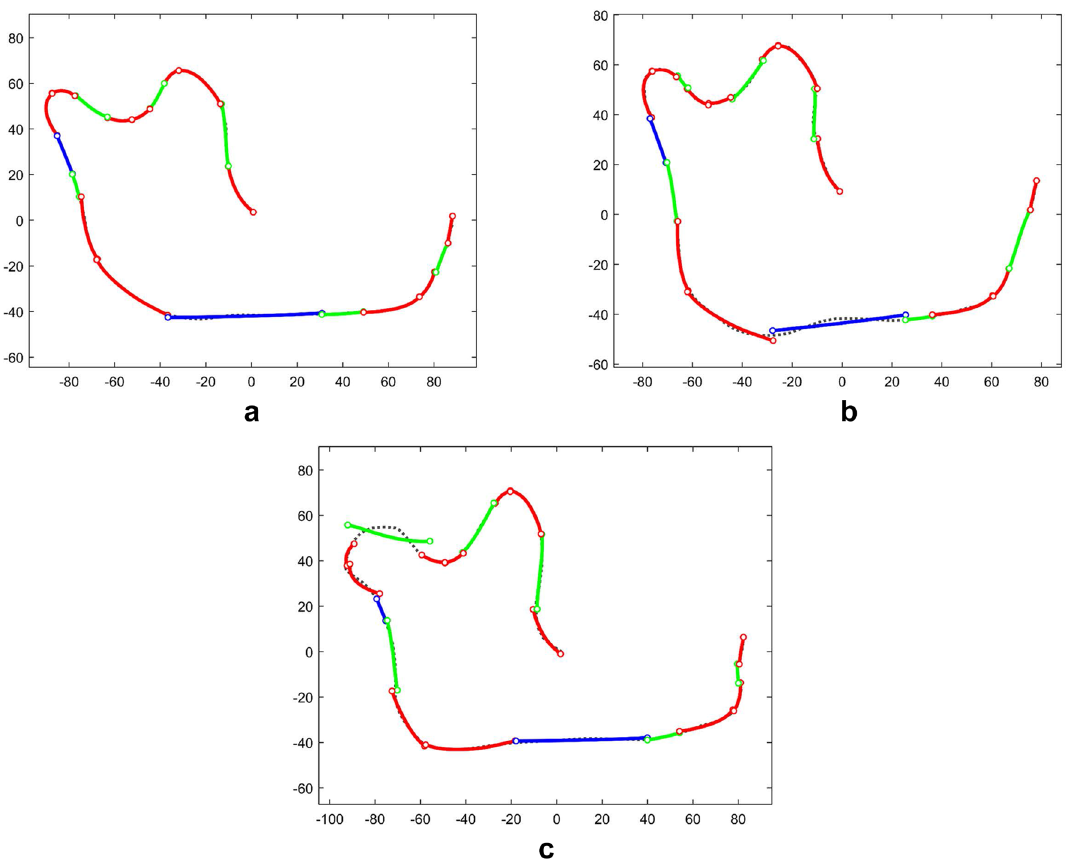
Figure 7. The fitting result of 94 human mandibles. ( a ) The best match (the 4th profile— H. erectus , ˜ E 4 = 0.3924 ); ( b ) The match with error closest to E (the 6th profile— H. erectus , ˜ E 6 = 0.6006 ); ( c ) The worst match (the 13th profile— H. heidelbergenis , ˜ E 13 = 1.0771